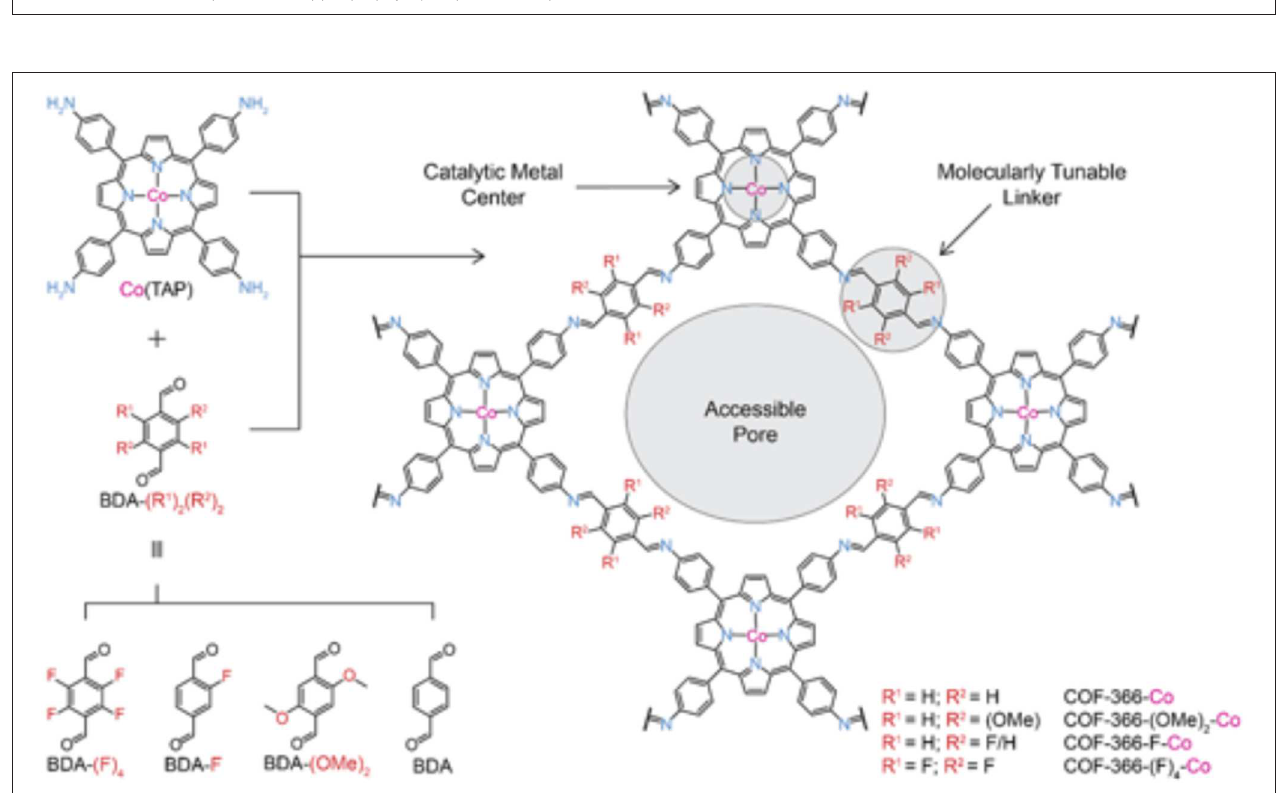
FIGURE 15 | The various inkers used by Diercks et al. (2018a) to produce a series of new Co-COFs. Reprinted with permission © 2018 The American Chemical Society.